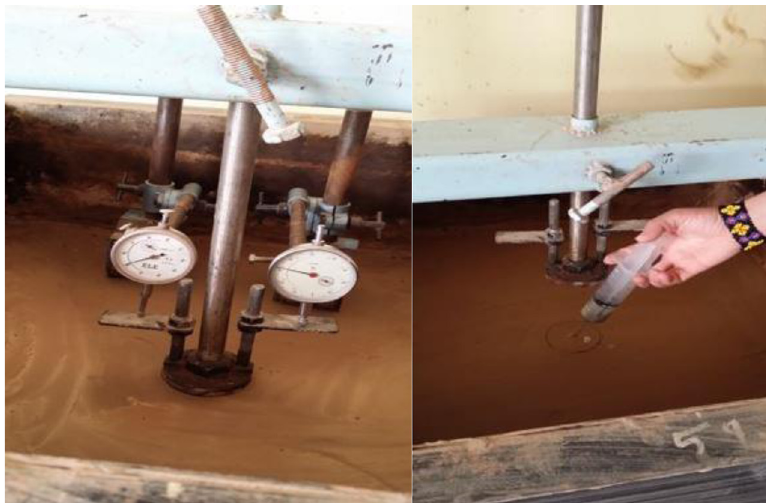
Figure 8: Rigid steel footing resting on the